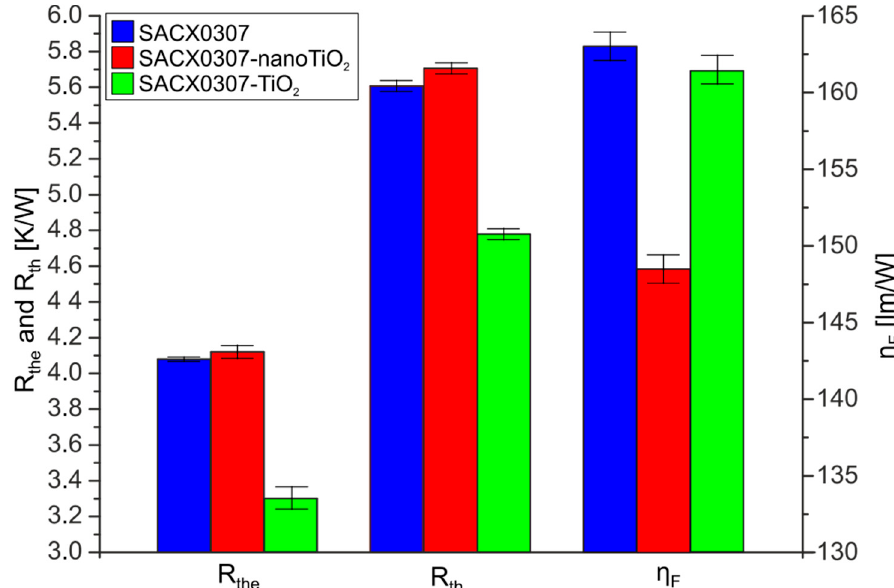
Figure 3. Thermal resistance ( R th ), electric thermal resistance ( R the ), and luminous efficiency (η F ) of the tested diodes soldered by different soldering pastes ( I Fmax = 5 A).